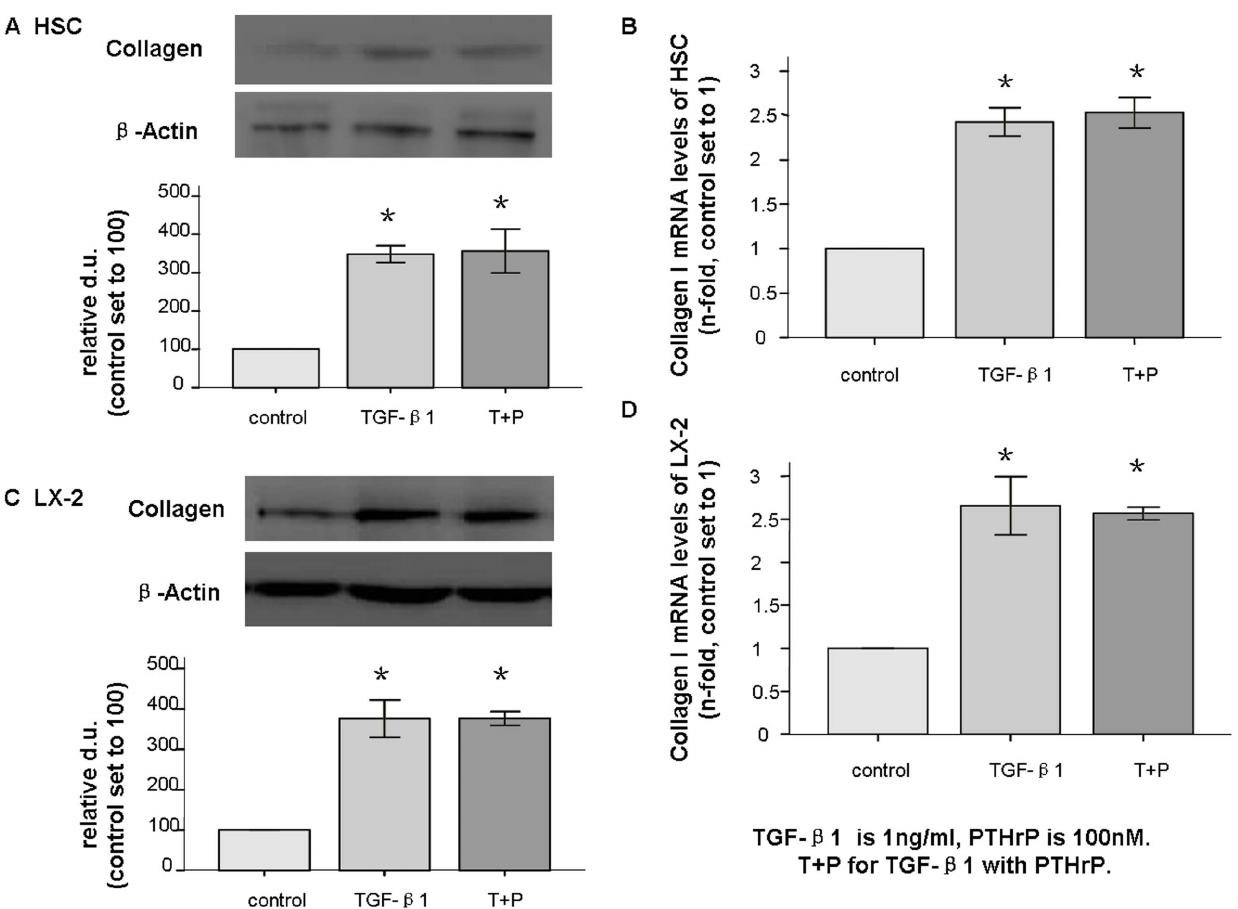
Figure 4. Collagen I expression in HSCs and LX-2 cells after TGF- b 1 and PTHrP treatment. After treatment with TGF- b 1 (1 ng/ml) alone or with PTHrP (100 nM) for 48 h, collagen I (138 kd) total protein was assessed by western blot (A); mRNA expression was measured with q-PCR and found to be increased in both HSCs (B), and LX-2 cells (C and D). * p , 0.05 compared to the control group. No significant difference was observed between treated